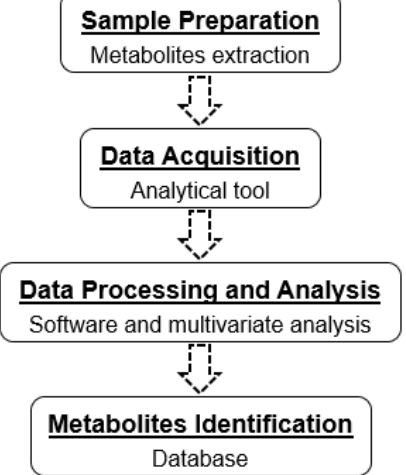
Figure 1. A workflow in metabolomics studies of fungal endophytes.